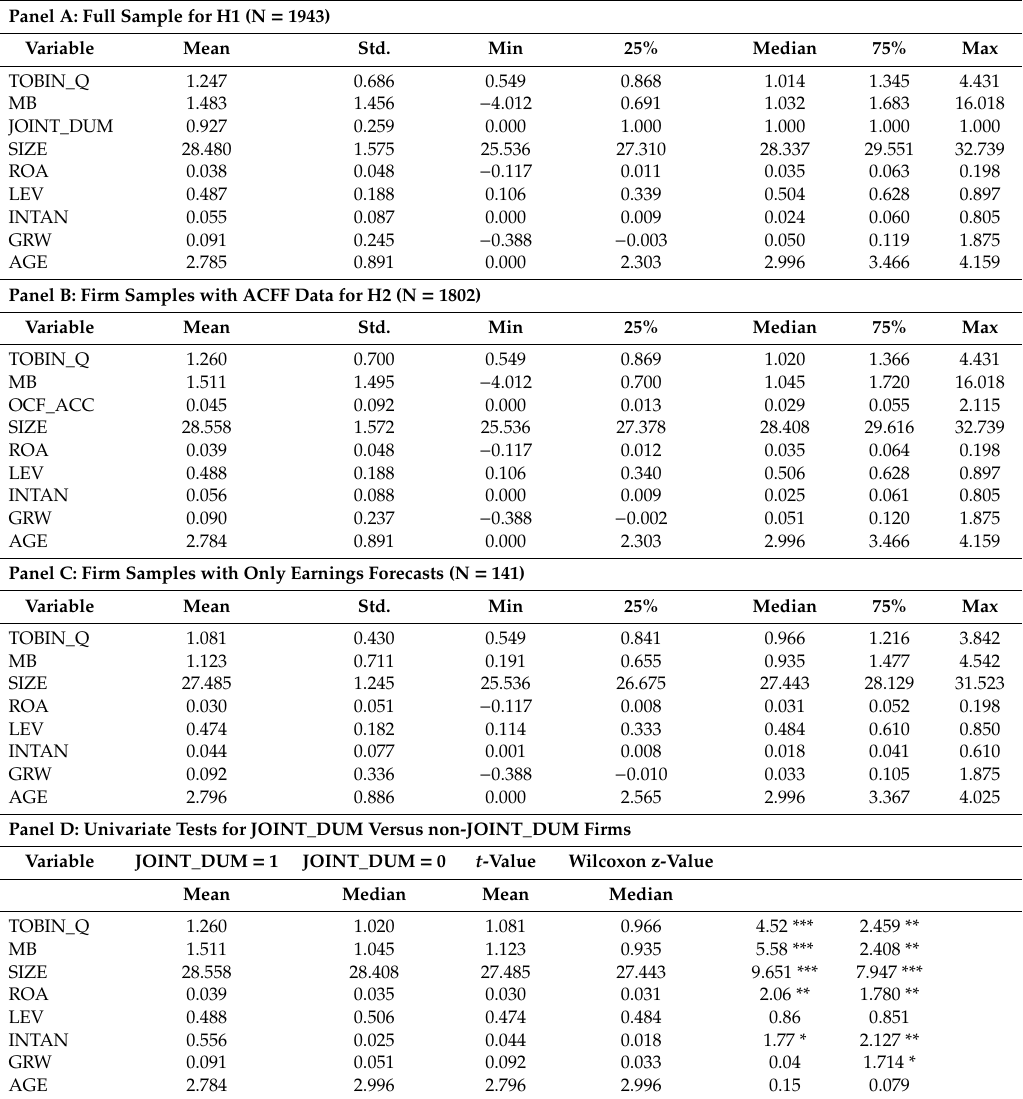
Table 3. Descriptive Statistics and Univariate tests.